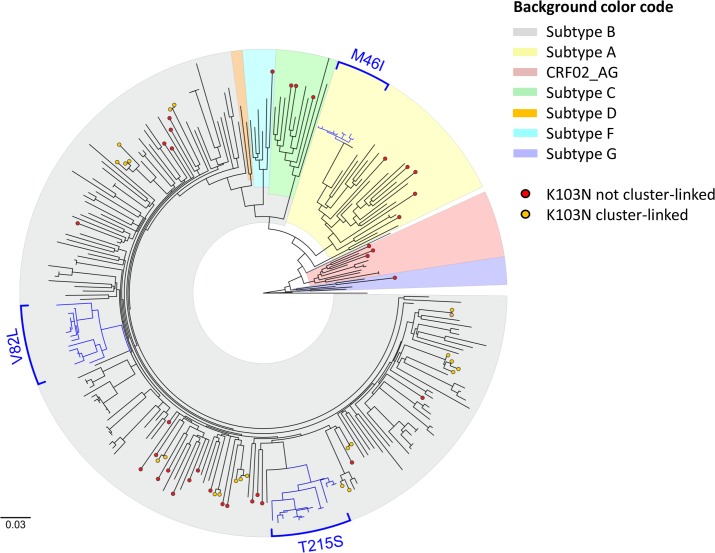
Phylogenetic analysis of 251 HIV-1 sequences carrying drug resistance mutations.Three large clusters with M46I, V82L or T215S mutations are shown with blue branches and all sequences carrying the K103N mutation are depicted with dots at the tips.